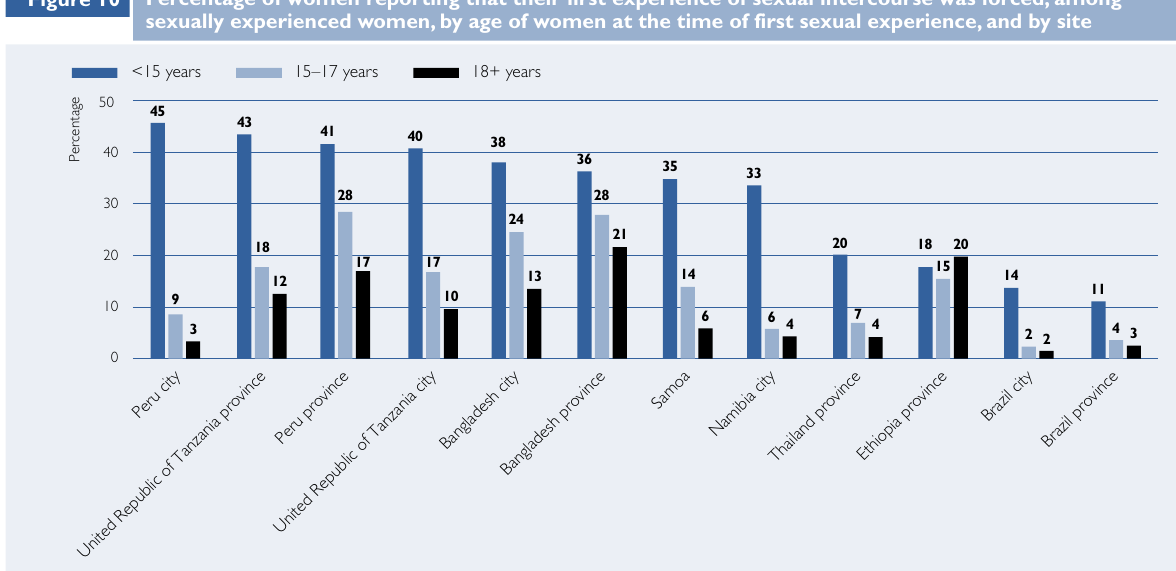
Percentage of women reporting that their first experience of sexual intercourse was forced, among sexually experienced women, by age of women at the time of first sexual experience, and by site